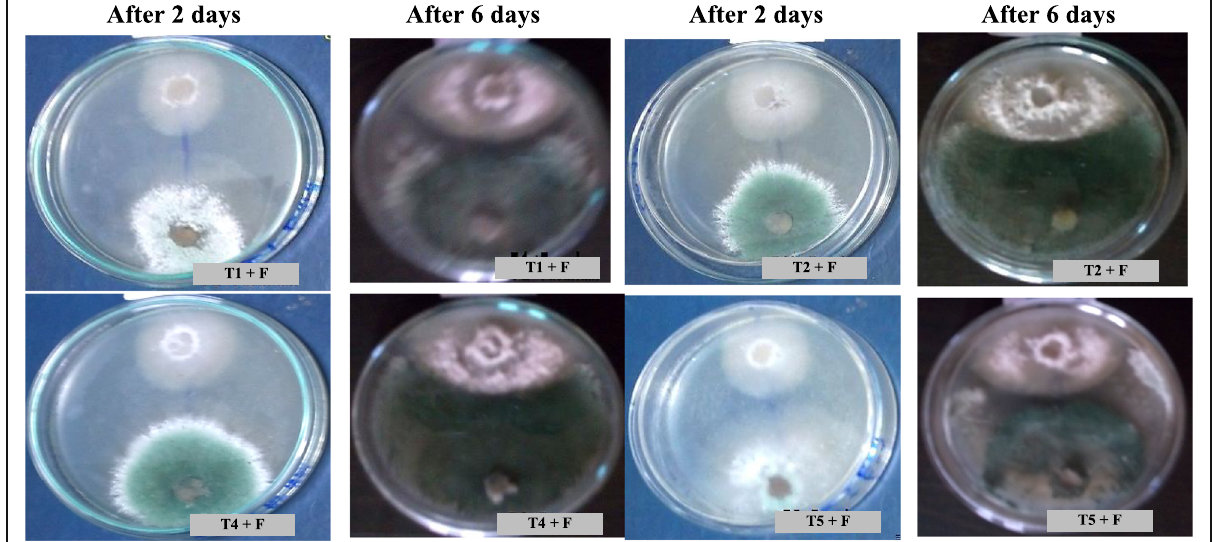
Fig. 3 Effect of Trichoderma antagonists on the mycelial growth of F. oxysporum (F) under in vitro conditions